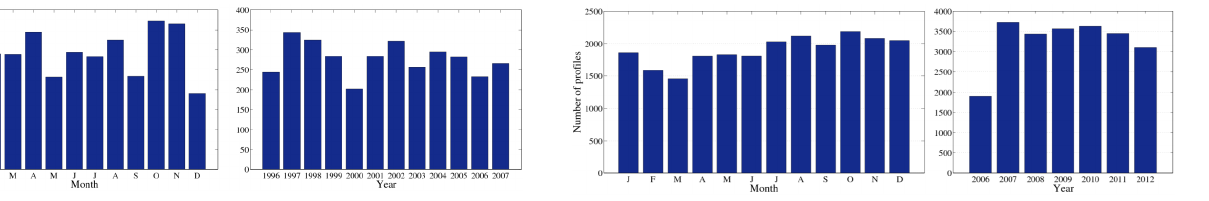
Figure 3. Total number of profiles obtained over OHP site during nighttime from CALIOP for 2 Fig. 3. Total number of profiles obtained over OHP site during each month (on the left) and year (on the right) over the period 2006-2012. 3 nighttime from CALIOP for each month (on the left) and year (on the right) over the period